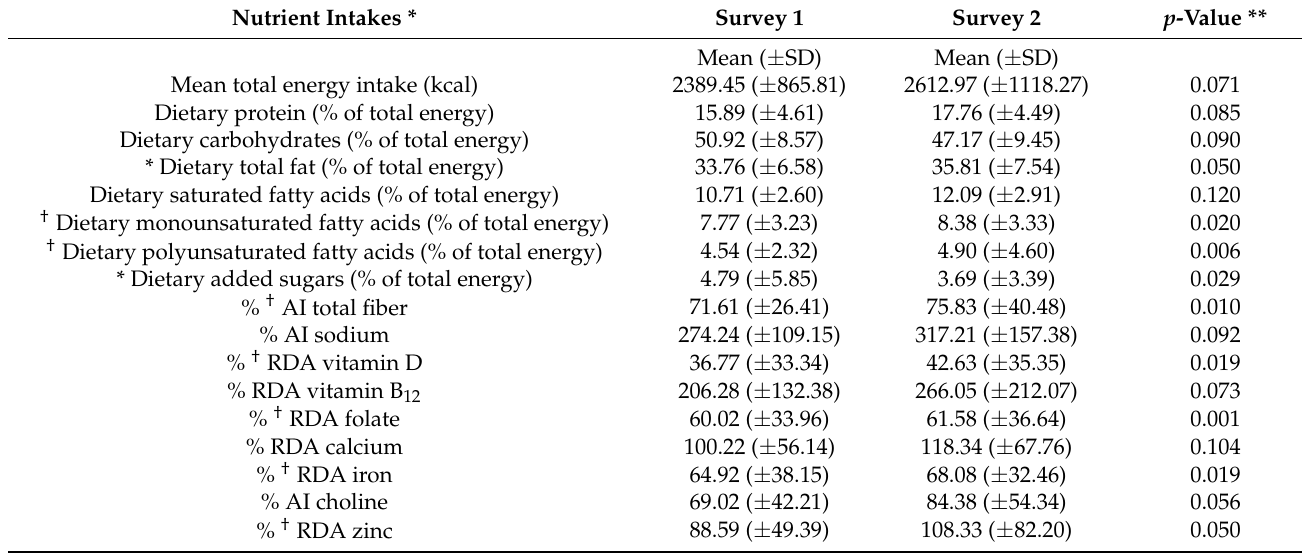
Table 4. Comparison of the nutrient intake of participants for survey 1 and survey